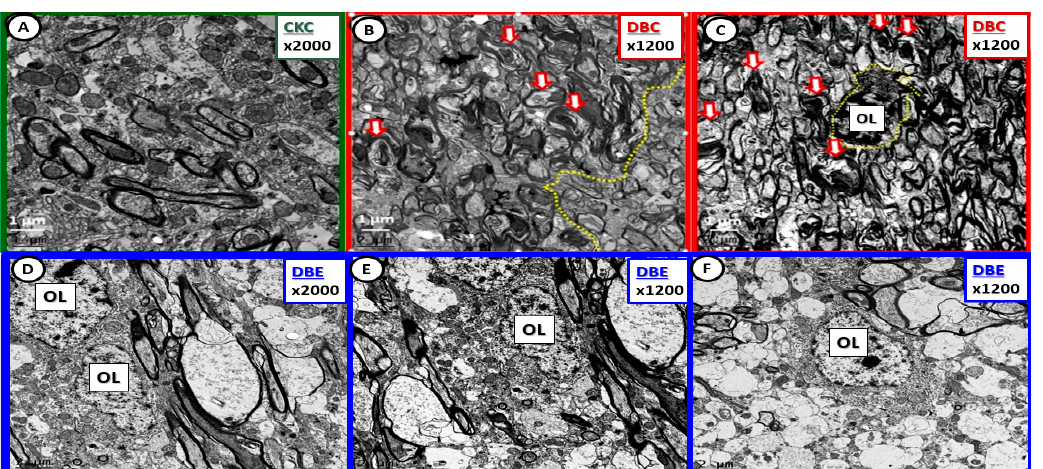
Figure 7. Cortical gray matter myelin remodeling was protected with empagliflozin treatment. Panels ( A ) and ( B ) demonstrate normal myelination and electron-dense mitochondria (Mt) in the cortical gray matter. Panels ( C ) and ( D ) depict marked myelin splitting and separation in DBC, and also note the aberrant mitochondria (aMt) within the axons (pseudo-colored yellow encircled by red outlines) as compared to the normal axonal mitochondria in CKC and DBC (pseudo-colored green with white outlines). Dysmyelination and aMt remodeling were prevented with empagliflozin treatment (panels ( E ), ( F )). Magnification 4000×; scale bar = 0.5 µm. Myelin disarray was a frequent observation in the transition zone subcortical white matter in DBC compared to CKC and DBE (Figure 8).